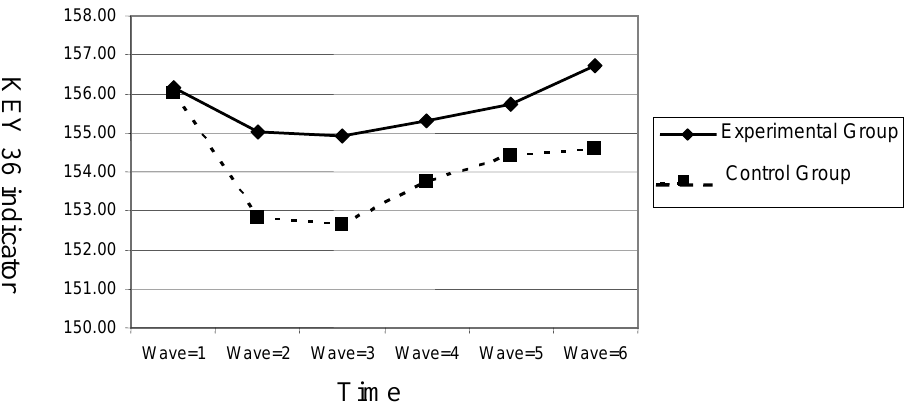
FIGURE 4 . Fitted trajectories of the control and experimental